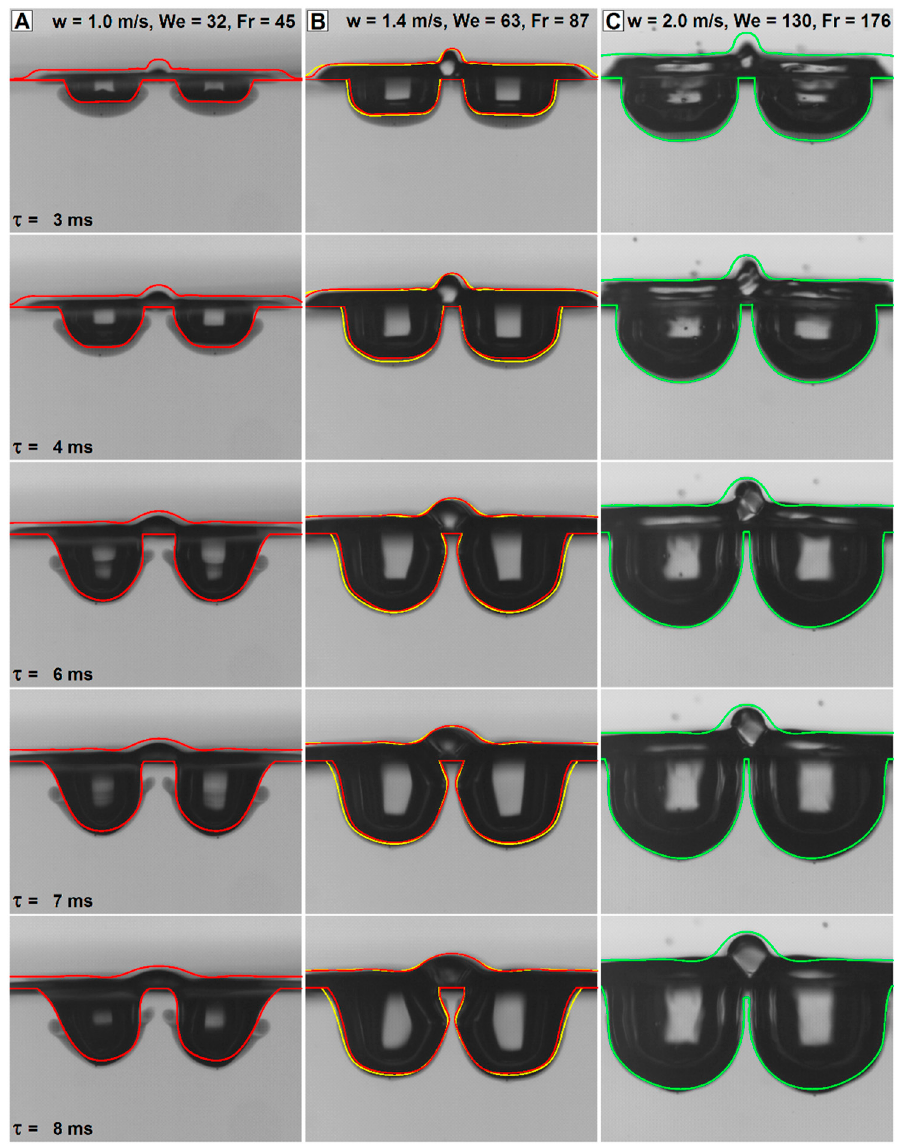
Figure 2. Superposition of the numerical crater contours to the experimental high-speed photos, for the three investigate cases A (w = 1.0 m/s), B (w = 1.4 m/s), C (w = 2.0 m/s), time up to 8 ms. In case B, the red line shows the results of the 12.35 Mcell simulation, while the yellow line shows the results of the 1.4 Mcell simulation.